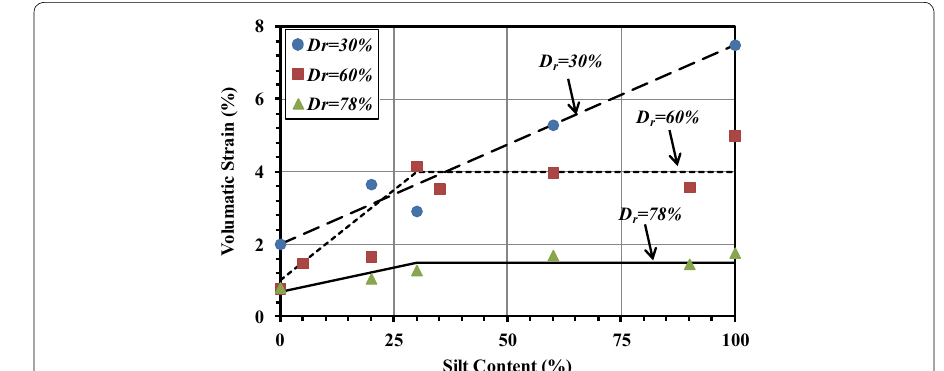
Fig. 7 Volumetric strain of specimen during consolidation phase